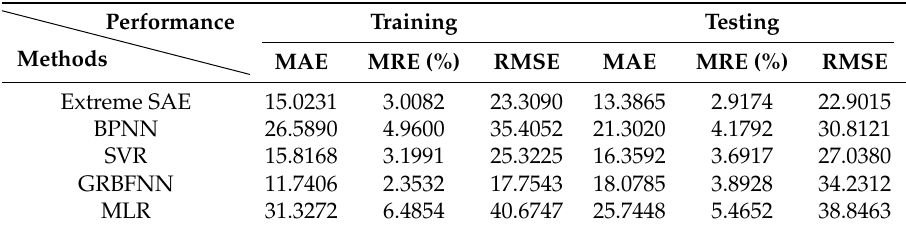
Table 2. Comparison results of the five prediction models in the 30 min prediction